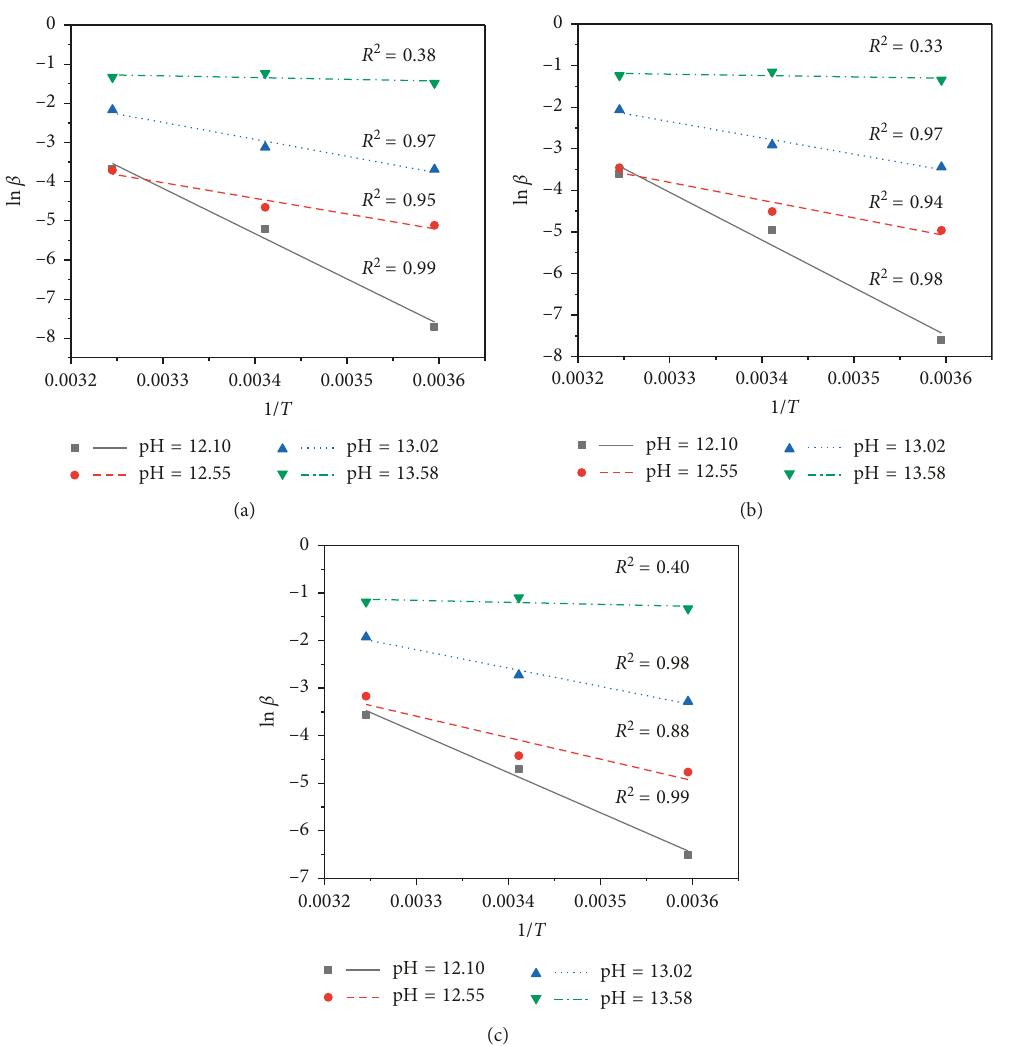
0.4; (b) w/s 0.5; (c) w/s (cid:31) (cid:31) (cid:31)